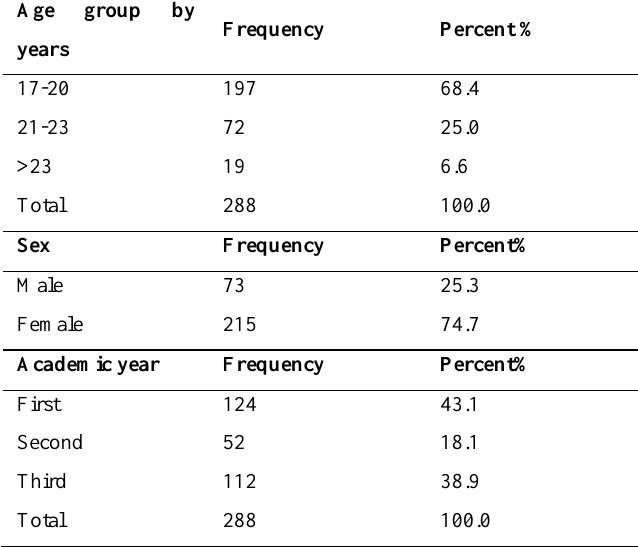
Table 1: Distribution of the study population according to age group, sex, and academic